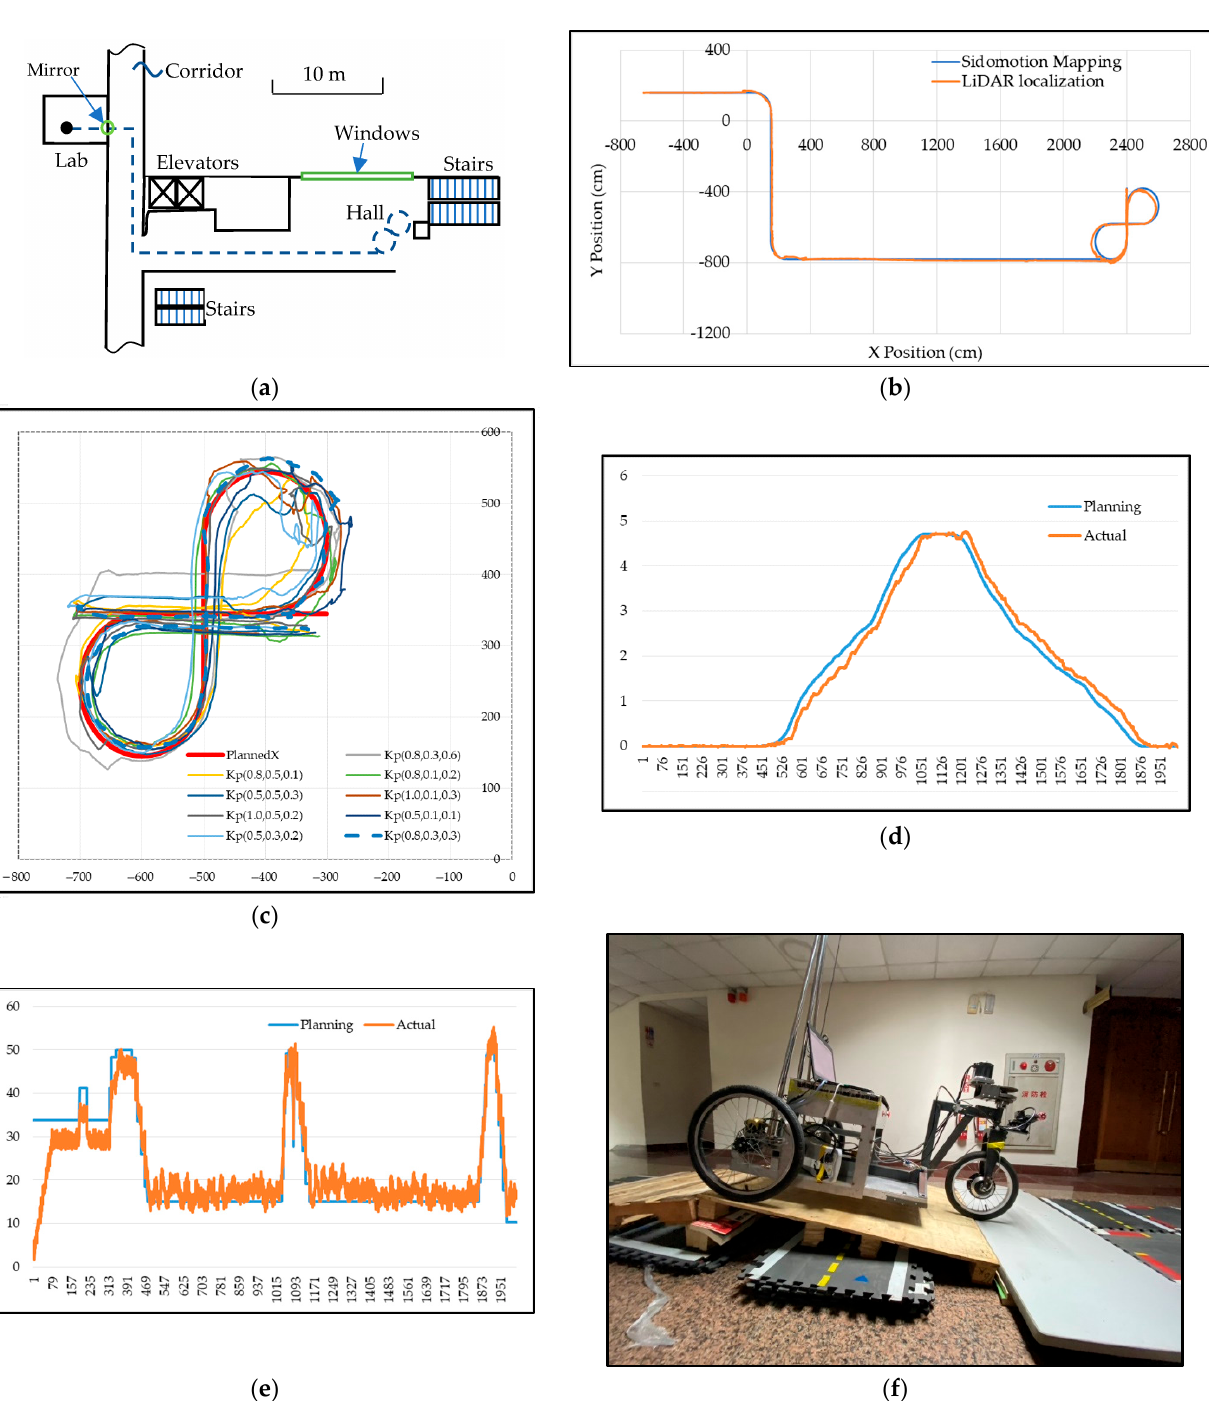
Figure 12. IMR navigation control: ( a ) floor plans of Engineering Building 5th Floor, NYCU; ( b ) path planning experiment data; ( c ) “8” figure test; ( d ) IMR orientation during navigation; ( e ) speed command sent to IMR according to Equation (26) compared with the trajectory velocity planning; ( f ) 10-degree ramp test.